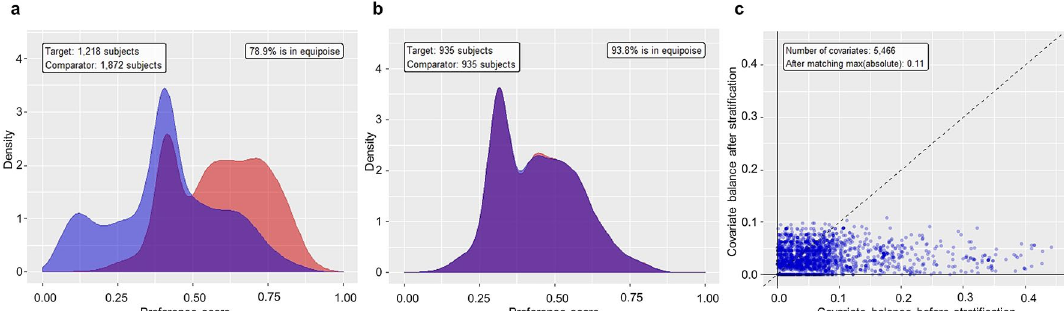
Figure 1. Diagnostics of propensity score matching performance. ( a ) Distribution of preference scores before propensity score matching. ( b ) Distribution of preference scores after propensity score matching. ( c ) Distribution of standardized mean differences in the means of individual covariates before and after stratification by propensity